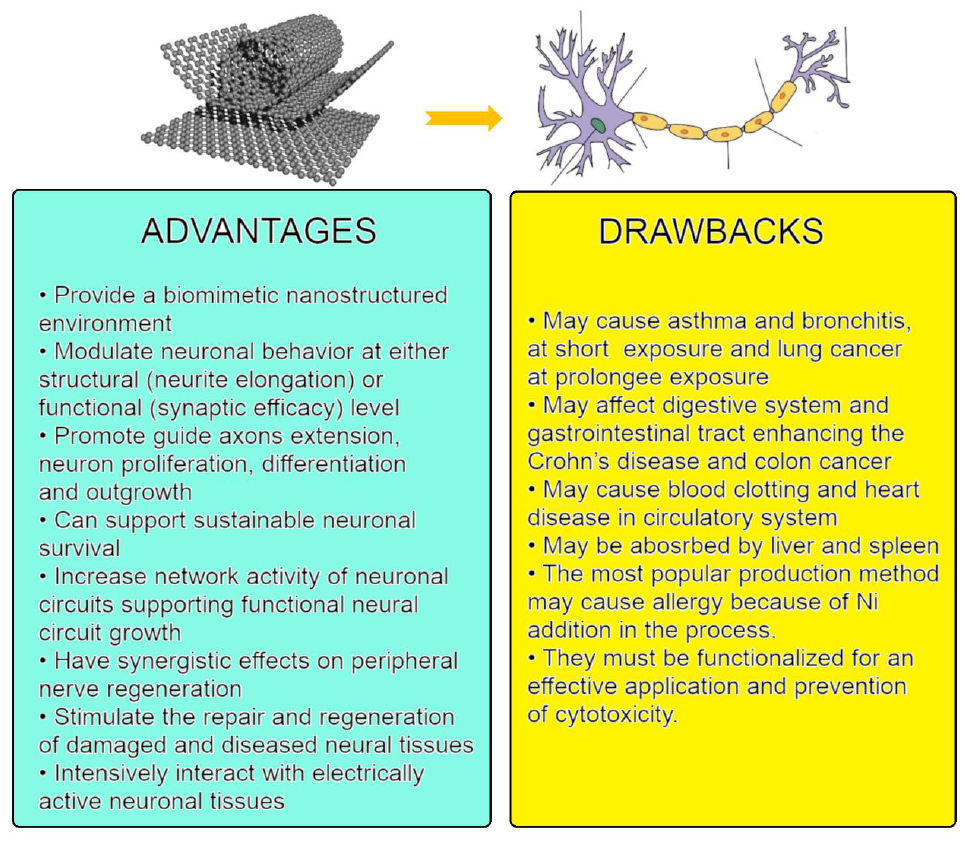
Figure 1. Scheme of anticipated interaction between carbon nanotubes and the nervous system: ad- vantages and drawbacks. Figures on the top are from: ( left ) Michael Berger. Carbon nanotubes – what they are, how they are made, what they are used for. https://www.nanowerk.com/nanotechnology/ introduction/introduction_to_nanotechnology_22.php (accessed on 28 September 2022); ( right ) Alex Bolano. Labeled Neuron Diagram. From: “Neuron” by US National Cancer Institute via WikiCommons CC BY-SA 3.0. https://sciencetrends.com/labeled-neuron-diagram/ (accessed on 28 September